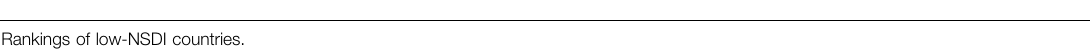
TABLE 7 | Rankings of low-NSDI